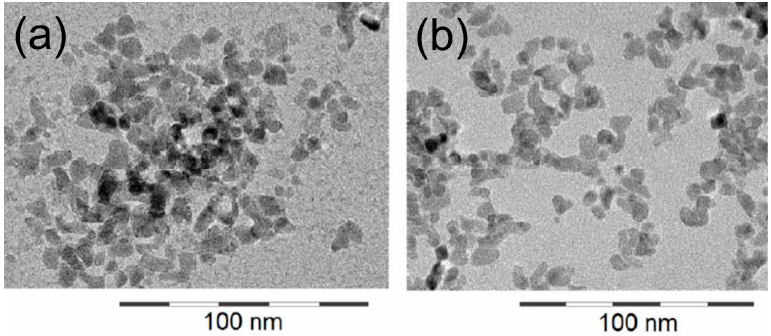
Figure 1. Transmission electron microscopic images of ZrO 2 -TODS ( a ) and ZrO 2 -Acryl ( b ). Images were taken from a previous characterization study [24].